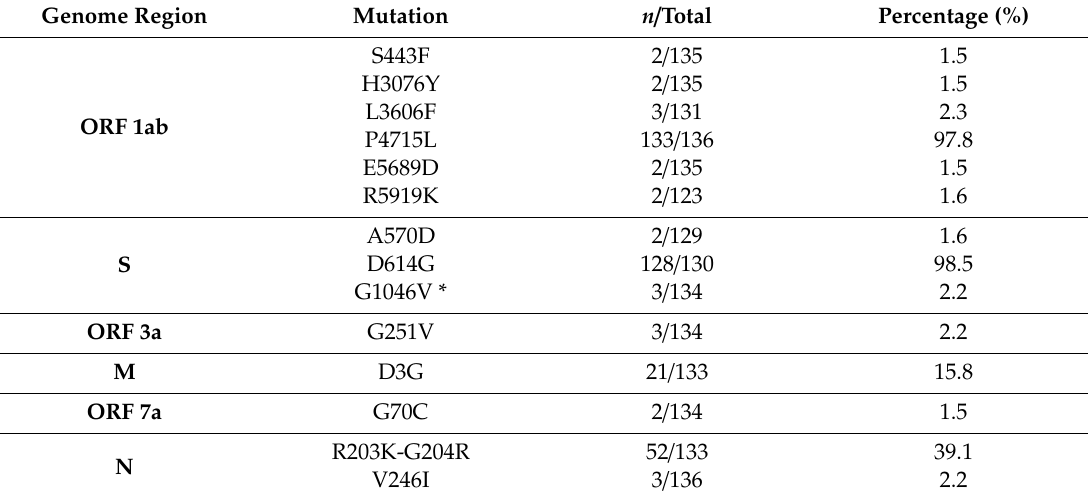
Table 3. SARS-CoV2 mutations identified in Italian